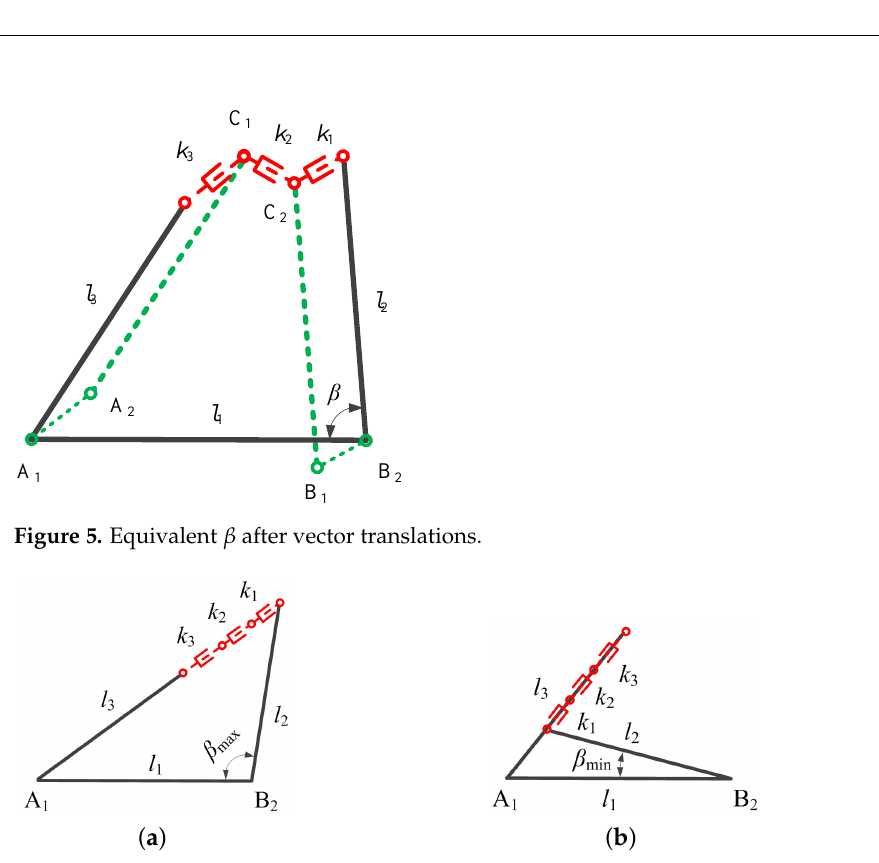
Figure 6. The extremal configurations. ( a ) Maximum. ( b ) Minimum. For the positional error boundary analysis, the workspace of point C 1 is studied in Figure 7 first.